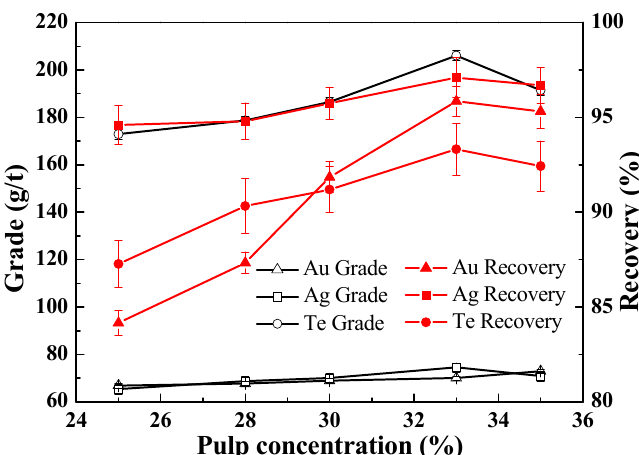
Figure 6. Flotation recovery and grade of Te, Au, and Ag as a function of pulp concentration value (content of − 0.074 mm (70%); pulp pH: 8; combined collector: sodium isoamyl xanthate + ethyl thio- carbamate (1:1) 120 g/t).